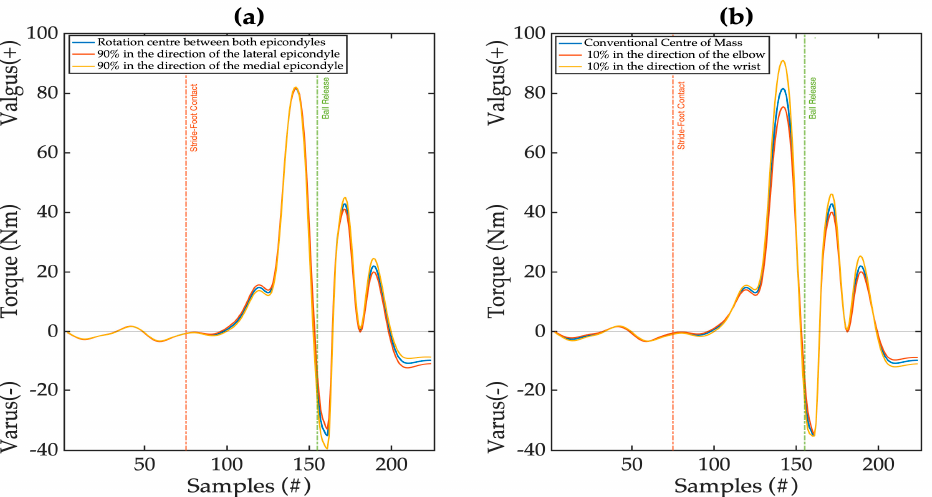
Figure 3. The effect of the location of the choice of the elbow rotation center during a baseball pitch (23 year-old pitcher, ball speed: 83 mph) on the varus–valgus torque. ( a ) One baseball pitch with three different simulated rotation centers. ( b ) The effect of the position of the center of mass on the varus– valgus torque, conventional simulation (blue line), based on Zatsiorsky regression equations